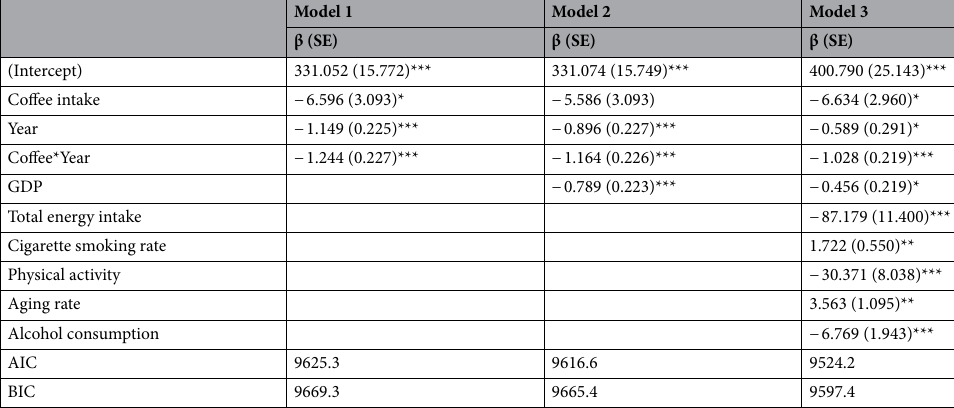
Table 3. Fixed effects of coffee intake, year, coffee intake–year interaction, and covariates on the IHD incidence rate per 100,000 population in the three linear mixed-effects models. Model 1: No covariates were adjusted. Model 2: GDP (US$1,000/capita) was adjusted. Model 3: GDP, total energy intake (1000 kcal/day/ capita), cigarette smoking rate (%), physical activity (1000 metabolic equivalents-min/week), aging rate (%), and alcohol consumption (grams of ethanol/day/capita) were adjusted. GDP gross domestic product, BMI body mass index, AIC Akaike’s information criterion, BIC Bayesian information criterion, SE standard error.